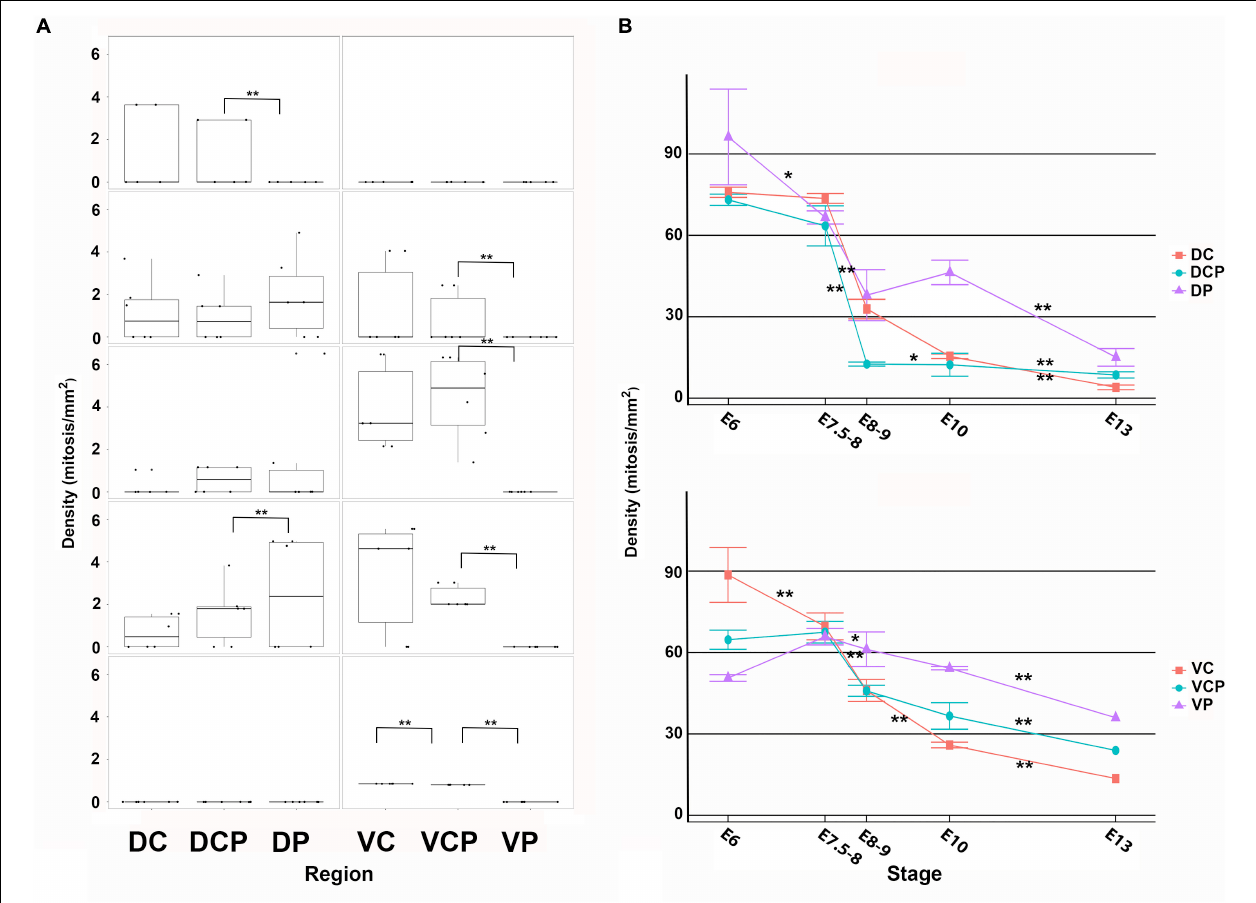
FIGURE 6 | Density values non-apical (A) and apical (B) mitoses in the developing retina of T. guttata. For each retinal region, boxplots of all samples are shown with the average, median, interquartile, and outliers. Notice that the non-apical mitoses spread following a dorsal-to-ventral gradient (A) . Intense mitotic activity was detected in the apical region of the ventral retina at advanced stages of development. Data are expressed as means ± s.e.m. Statistical significance is indicated by asterisks (* p < 0.05, ** p <